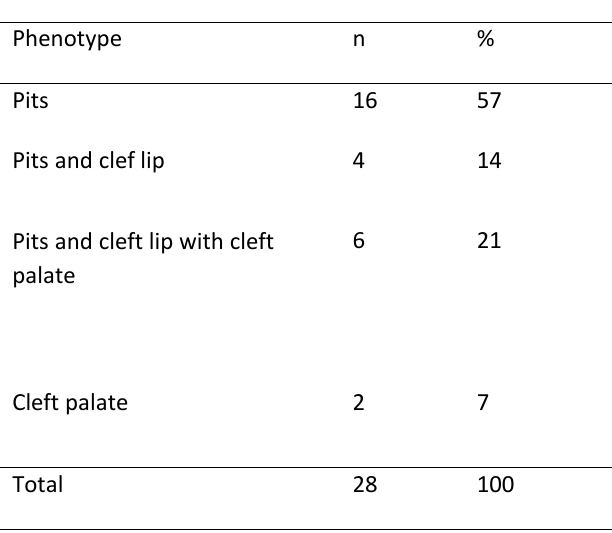
Table 1. Phenotypic characteristics of Van der Woude Syndrome present in affected family